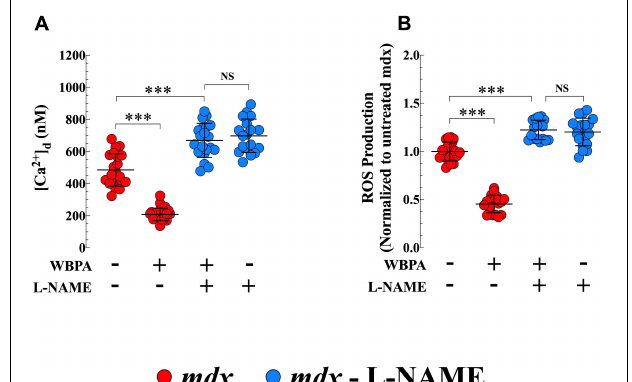
FIGURE 6 | L-NAME pretreatment abolished the cardioprotection induced by WBPA. Pretreatment of dystrophin-deficient mdx mice with L-NAME abrogated the beneficiary effect of WBPA on diastolic [Ca 2 + ] (A) and intracellular ROS production (B) . Interestingly, L-NAME pretreatment aggravated the [Ca 2 + ] d overload and oxidative stress in mdx cardiomyocytes (A,B) . [Ca 2 + ] d measurements : Untreated and WBPA-treated mdx , N = 4 mice per experimental condition , n = 21–24, respectively; L-NAME and WBPA pretreated mdx N = 5 mice, n = 20; L-NAME pretreated mdx N = 4 mice, n = 18. ROS measurements : Untreated and WBPA-treated mdx , N = 3 mice per experimental conditions , n = 20–18, respectively; L-NAME and WBPA pretreated mdx N = 4 mice, n = 17; L-NAME pretreated mdx N = 3 mice, n = 17. Values are expressed as means ± S.D. One-way ANOVA with Tukey’s post-test, *** p ≤